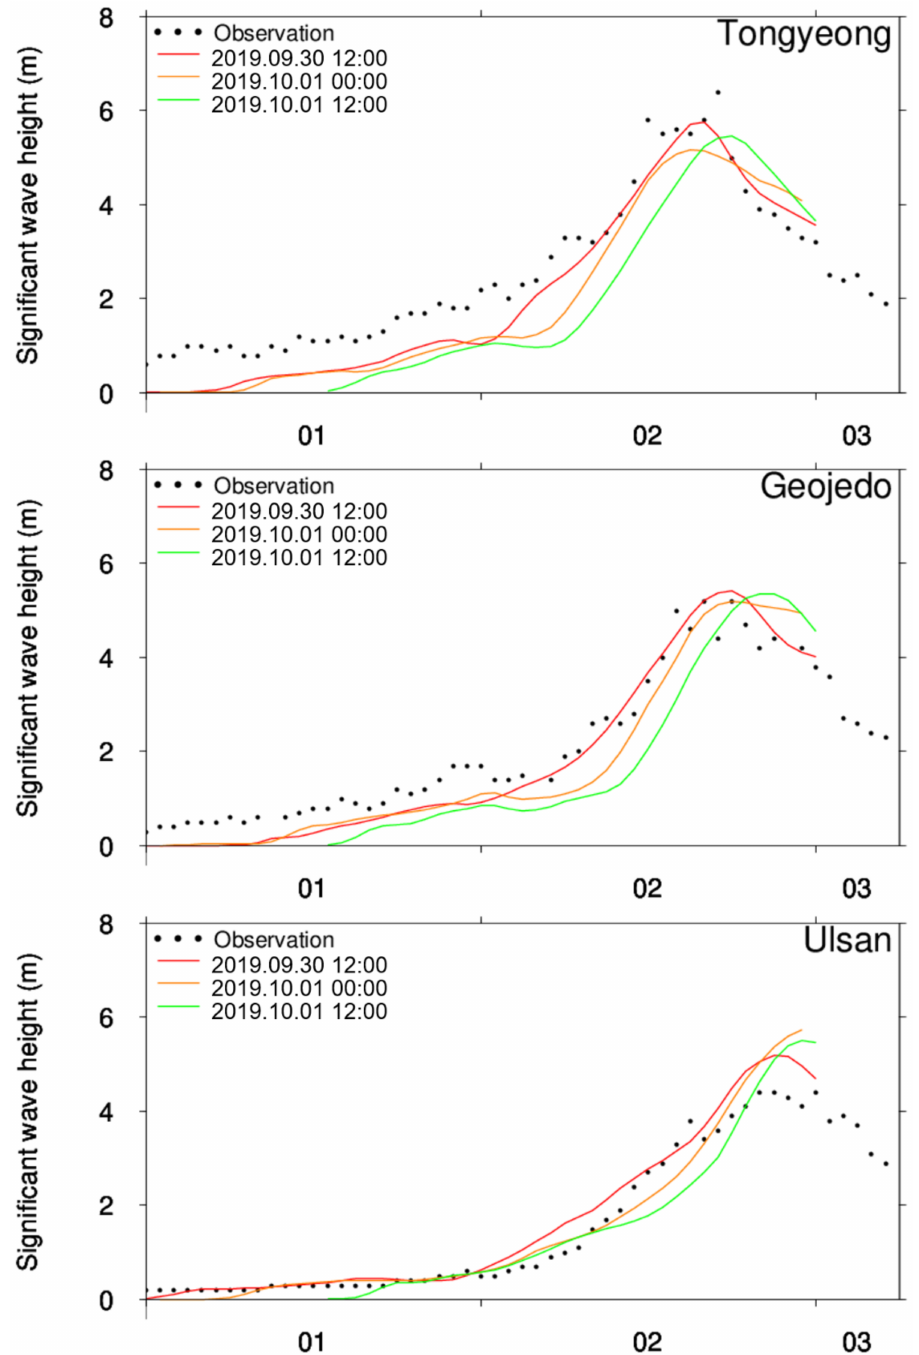
Figure 8. Comparison of ADCIRC+SWAN forecasts of significant wave height (m) with the moored buoy observations (Tongyeong, Geojedo, and Ulsan stations) for the case of Mitag. Here, the x-axis indicates the time with the date of simulation period and the interval of observation data is one